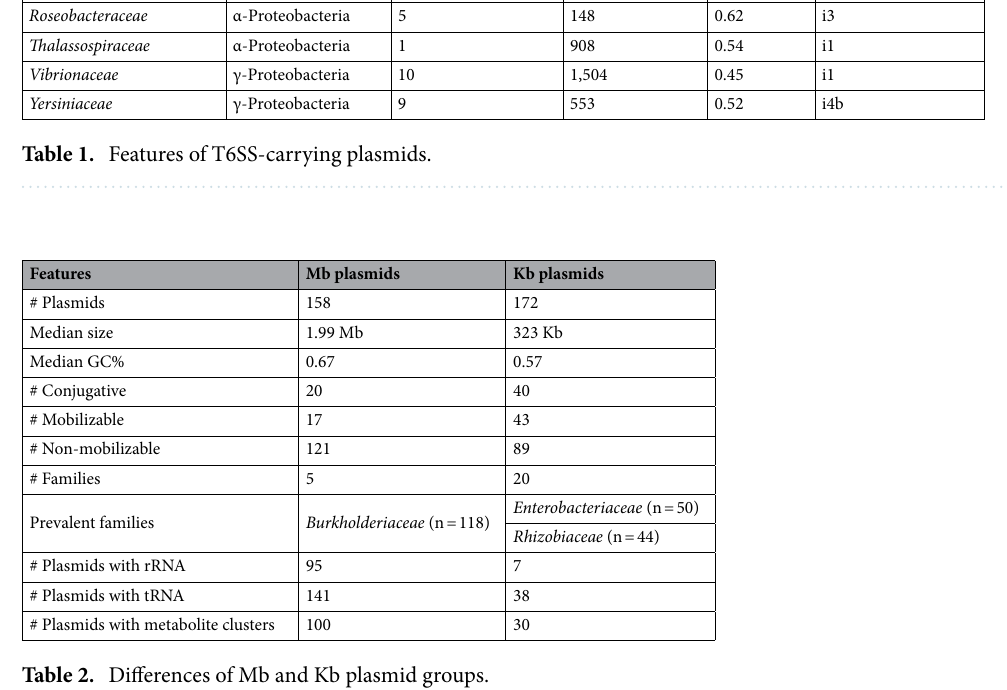
Table 2. Differences of Mb and Kb plasmid